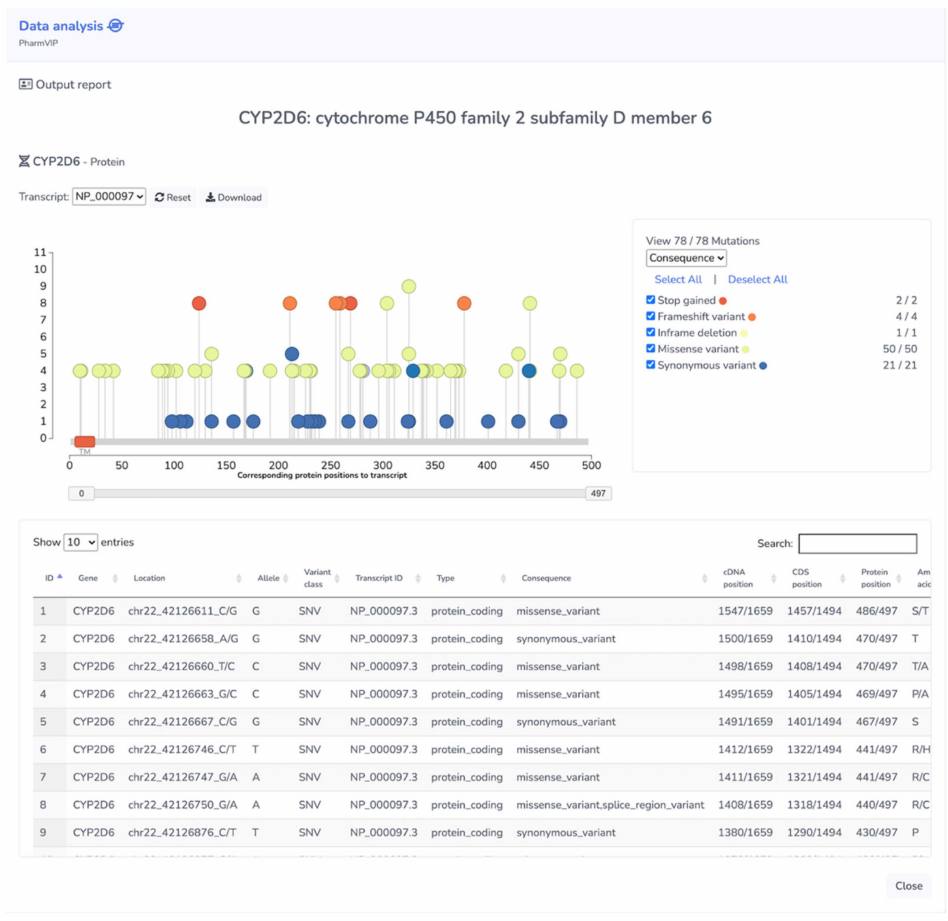
Figure 5. Lolliplot of the CYP2D6 gene showing genetic variants. In the “gene” view option of the Pharmacogenes module, a lolliplot displays the locations of the 78 genetic variants along the CYP2D6 gene region. The displayed variants can be filtered by variant consequences, which are illustrated by color code, and the variant impact levels, which are represented by the height of the plot on the y -axis (Low = 1, Moderate = 4, High =